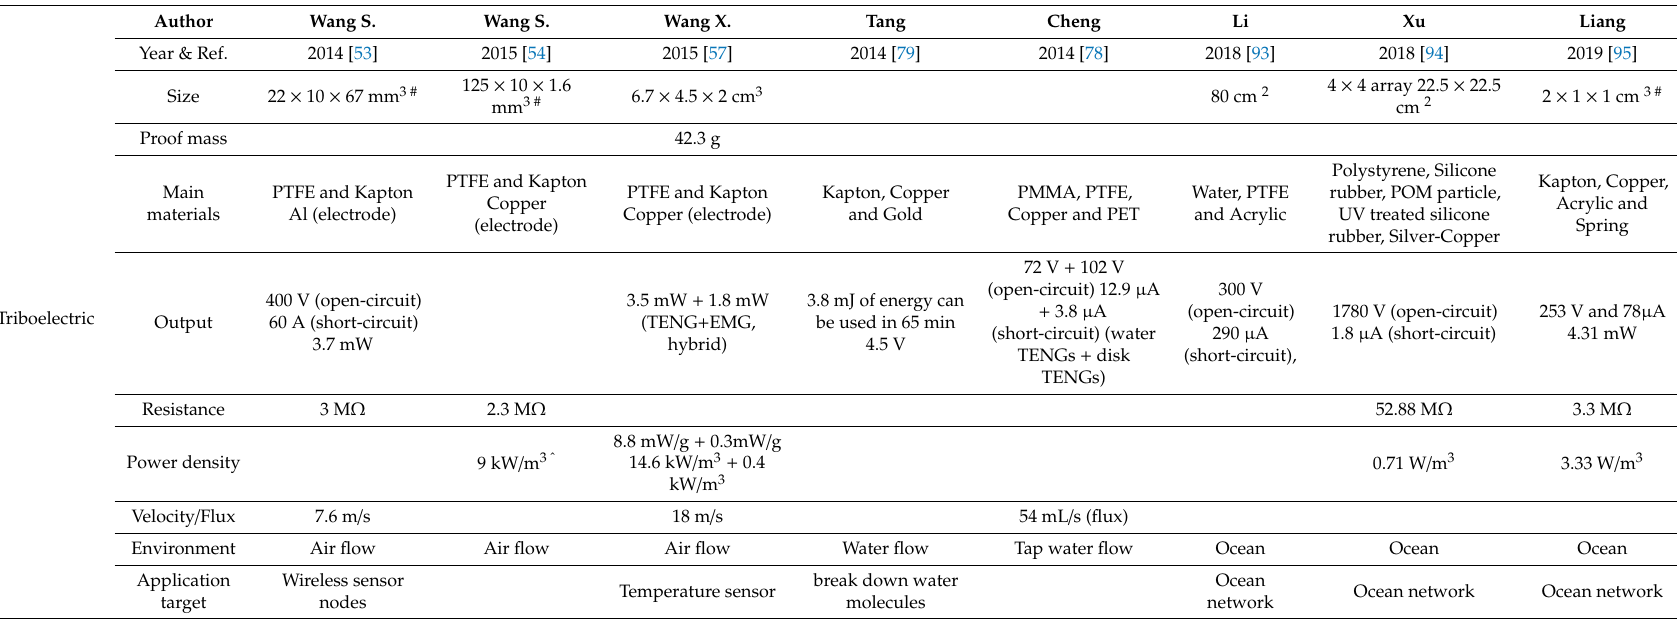
Table 2. Triboelectric nanogenerators (TENG) and the TENG